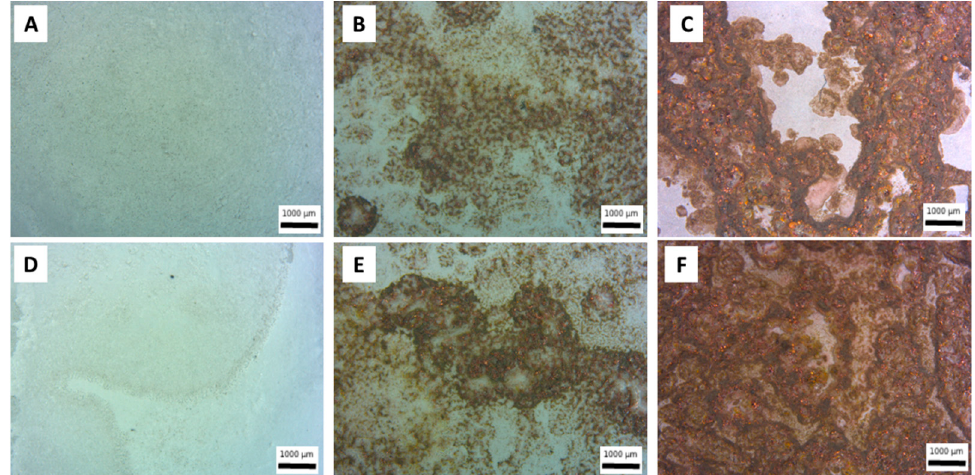
Figure 2. Stereo microscope images of the surfaces of PEO coatings obtained working at 0.5 A/cm 2 in DC mode without particles ( A ), with large particles ( B ) and with small particles ( C ) and working at 1 A/cm 2 in UPC without particles ( D ), with large particles ( E ) and with small particles ( F ).